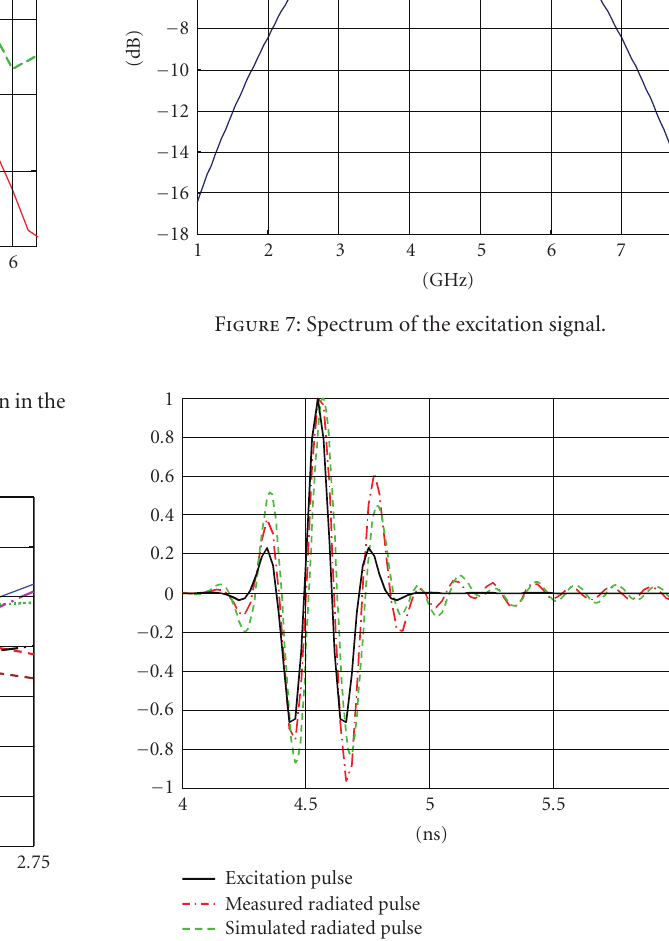
Figure 8: Excitation signal and radiated field in the main lobe di-